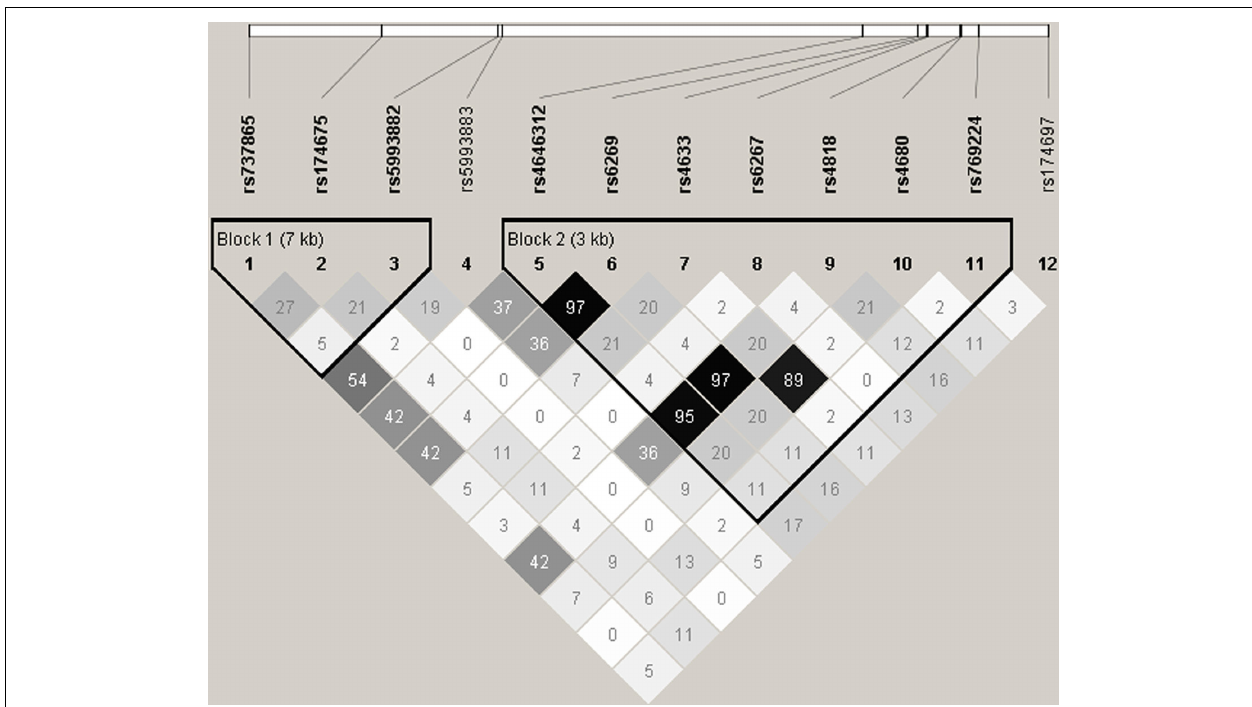
FIGURE 1 | Linkage disequilibrium (LD) pattern of the 12 COMT SNPs analyzed in the present study. Numbers in squares designate the degree of LD ( r 2 ) between any two SNPs. LD blocks were defined using the solid spine of LD algorithm implemented in